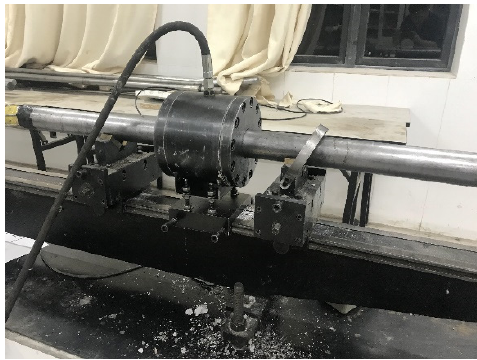
Figure 2. Confining pressure device.